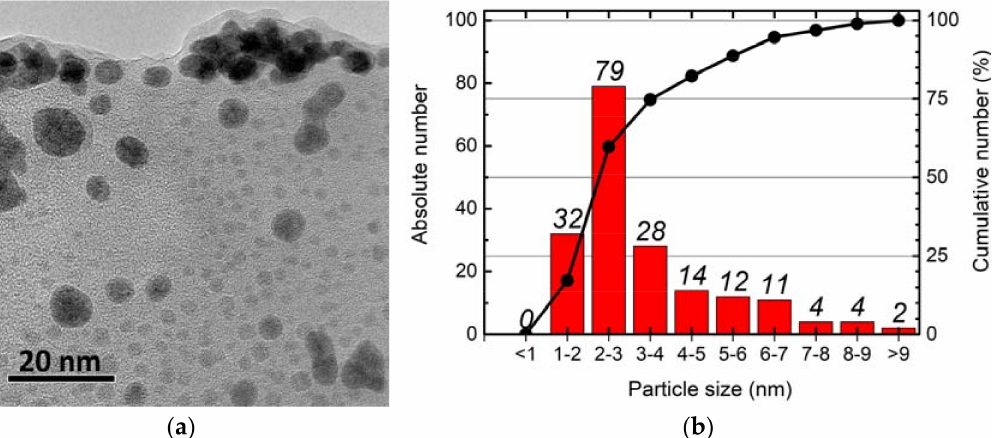
Figure 3. eBNPs visualized by TEM (magnification × 1.5 million) ( a ) and nanoparticle size distribution ( b